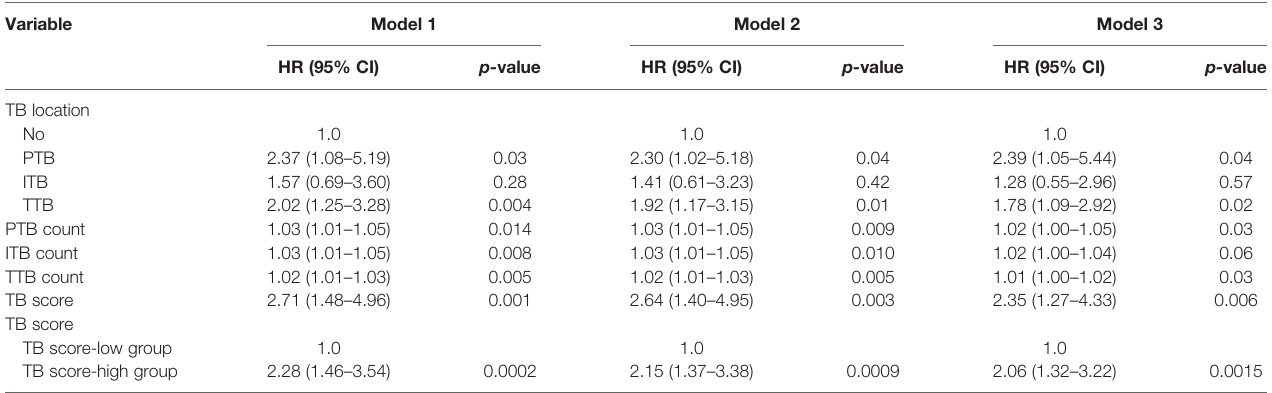
TABLE 4 | Relationship between the budding and overall survival in different models.